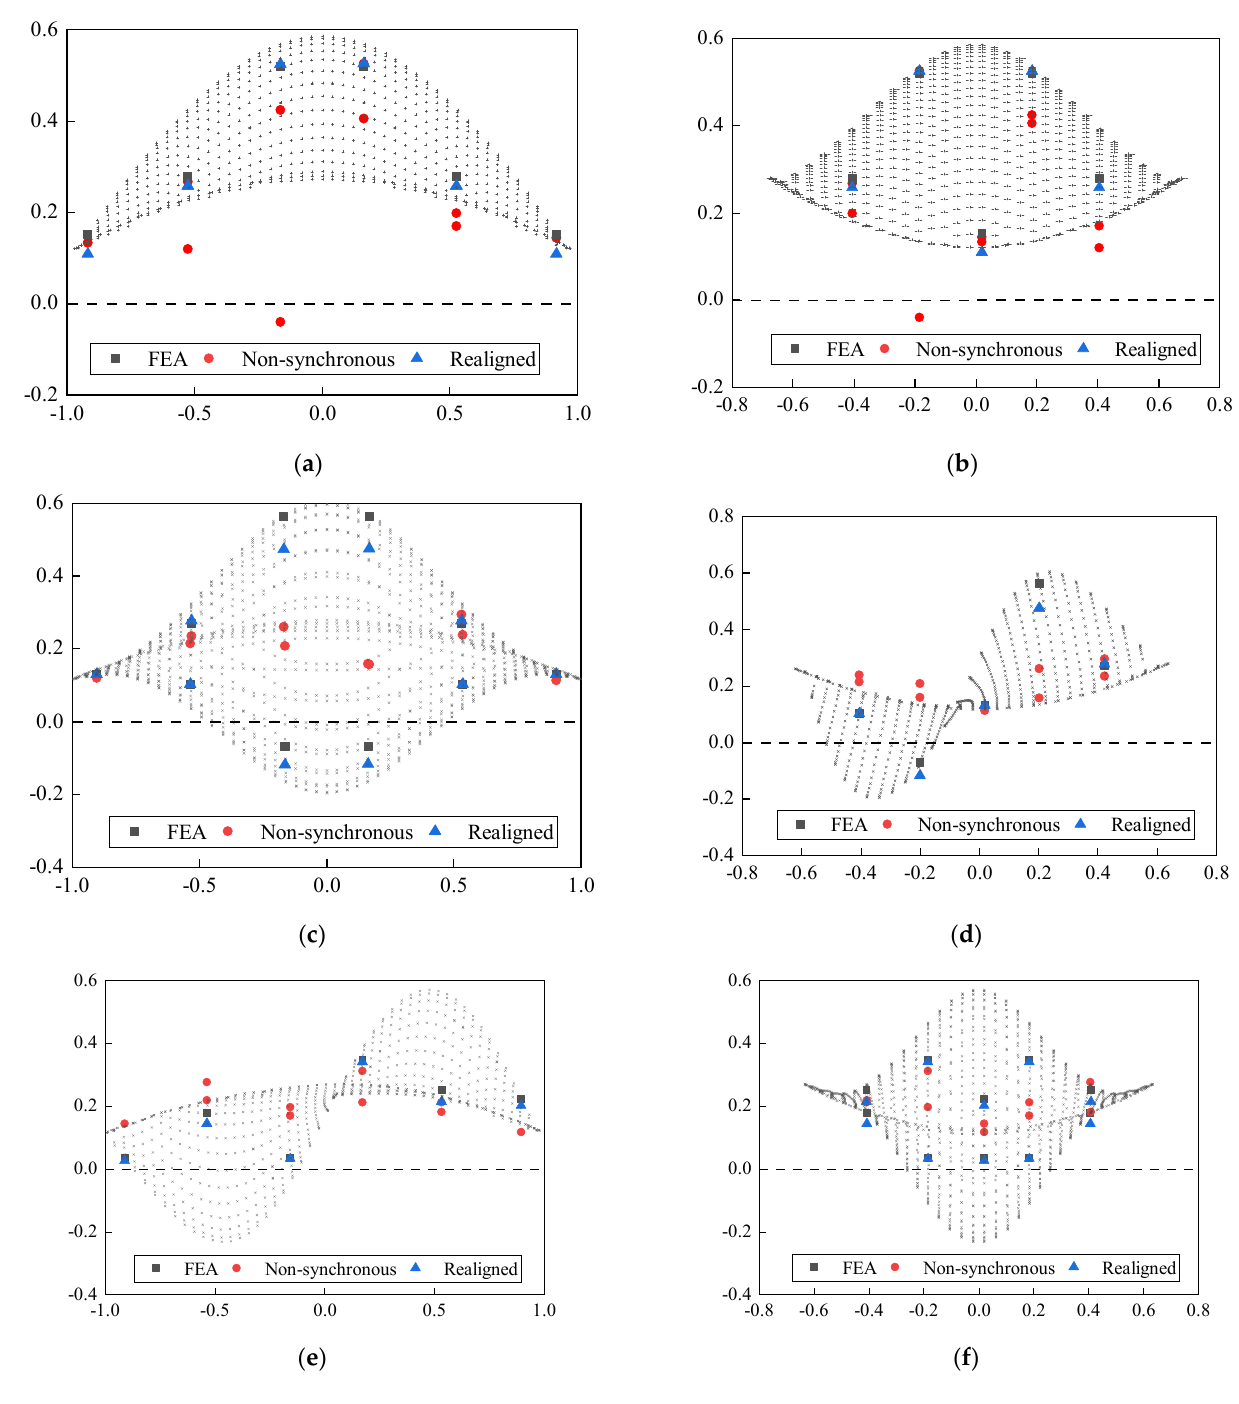
Figure 19. Mode shapes of the first 3 modes of NSSO identified from aligned acceleration and rea- ligned acceleration: ( a ) 1st mode-aligned, ( b ) 1st mode-realigned, ( c ) 2nd mode-aligned, ( d ) 2nd mode-realigned, ( e ) 3rd mode- aligned, and ( f ) 3rd mode-realigned.